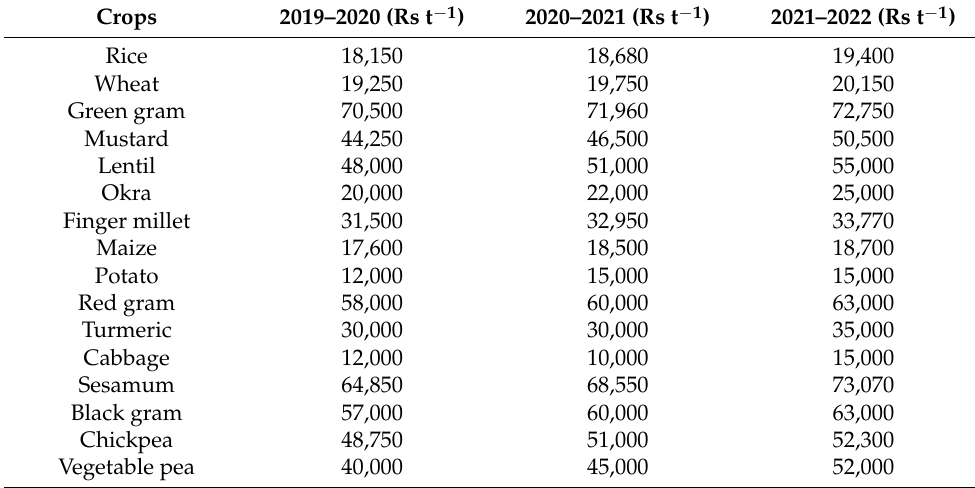
Table 3. Minimum support price and prevailing market price of produce during the respective year of experimentation